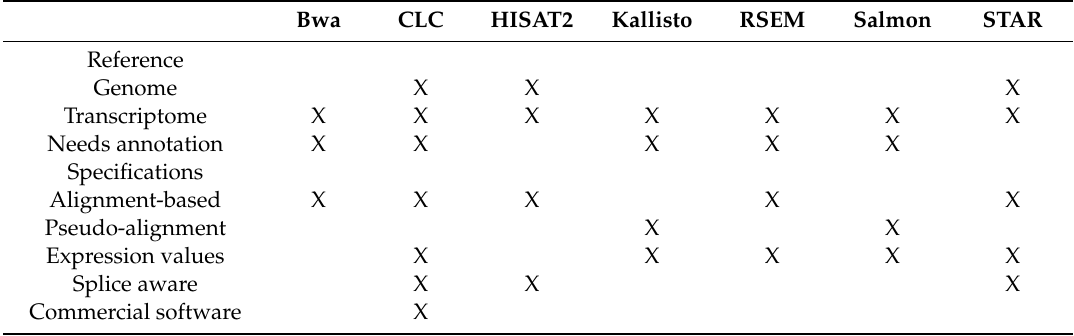
Table 3. Comparison of selected key features of the used mappers. Features indicated by X are included in the specified mapper.